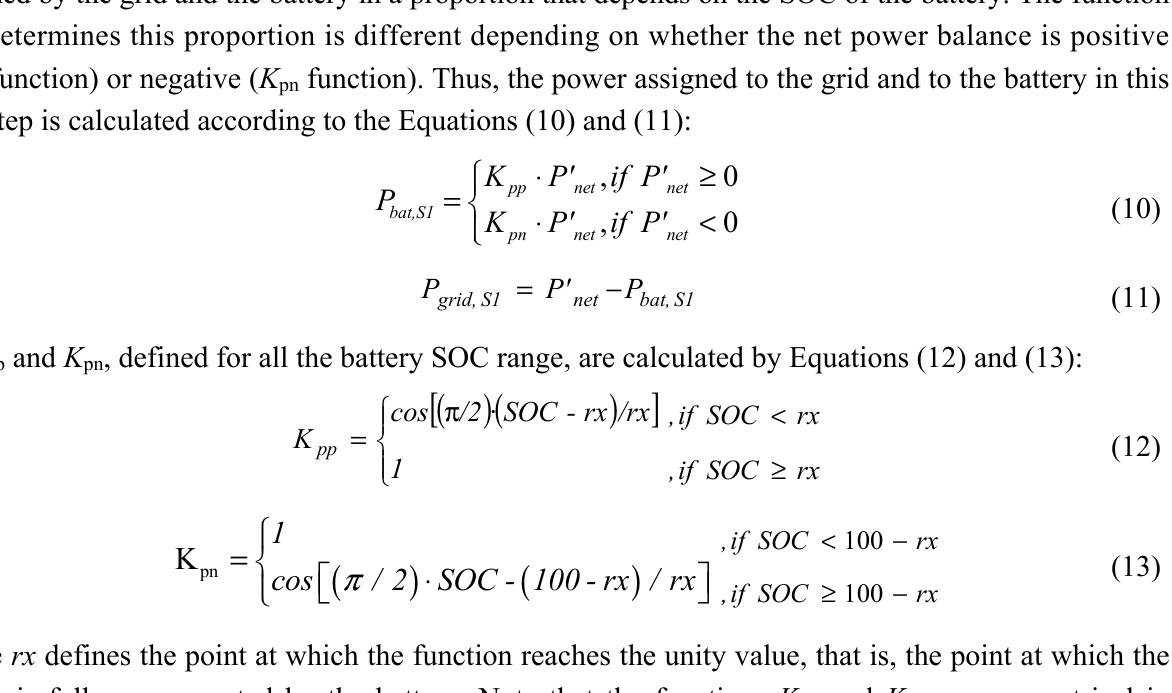
Figure 11. Evaluating functions, K